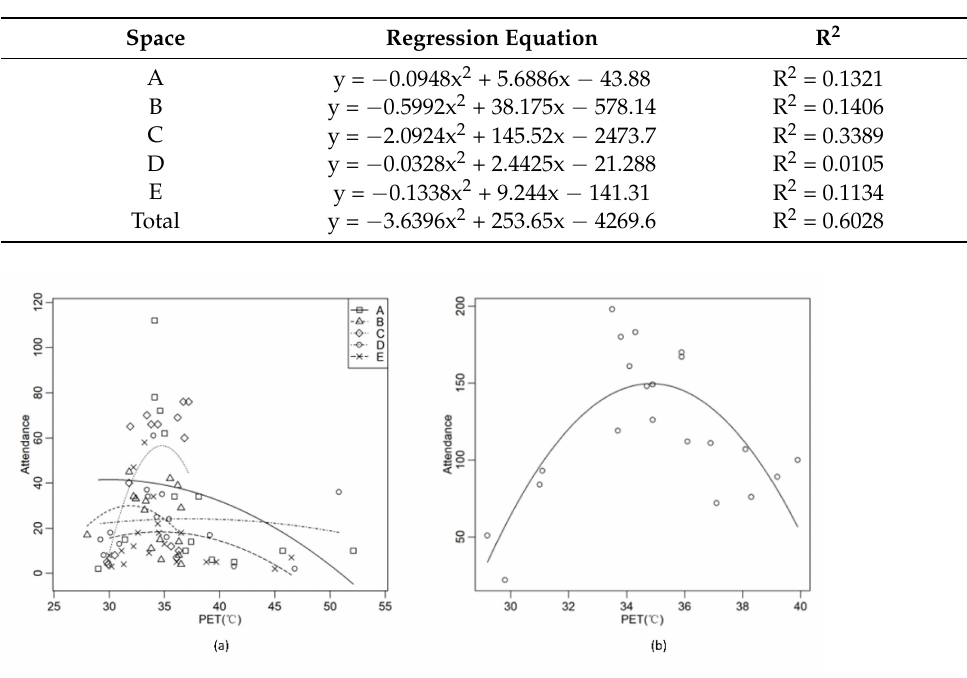
Table 4. Regression equation for PET and attendance.